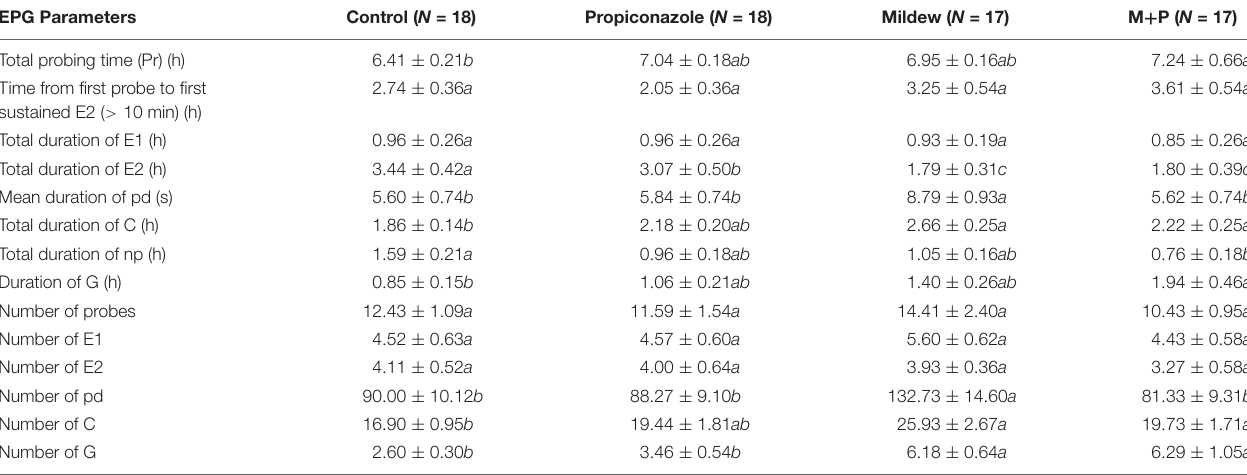
TABLE 1 | Mean ( ± SE) sequential EPG variable values for the probing behavior of Sitobion avenae on four treatments wheats during an 8-h recording. EPG Parameters Control ( N = 18) Propiconazole ( N = 18) Mildew ( N = 17) M + P ( N = 17) Total probing time (Pr)